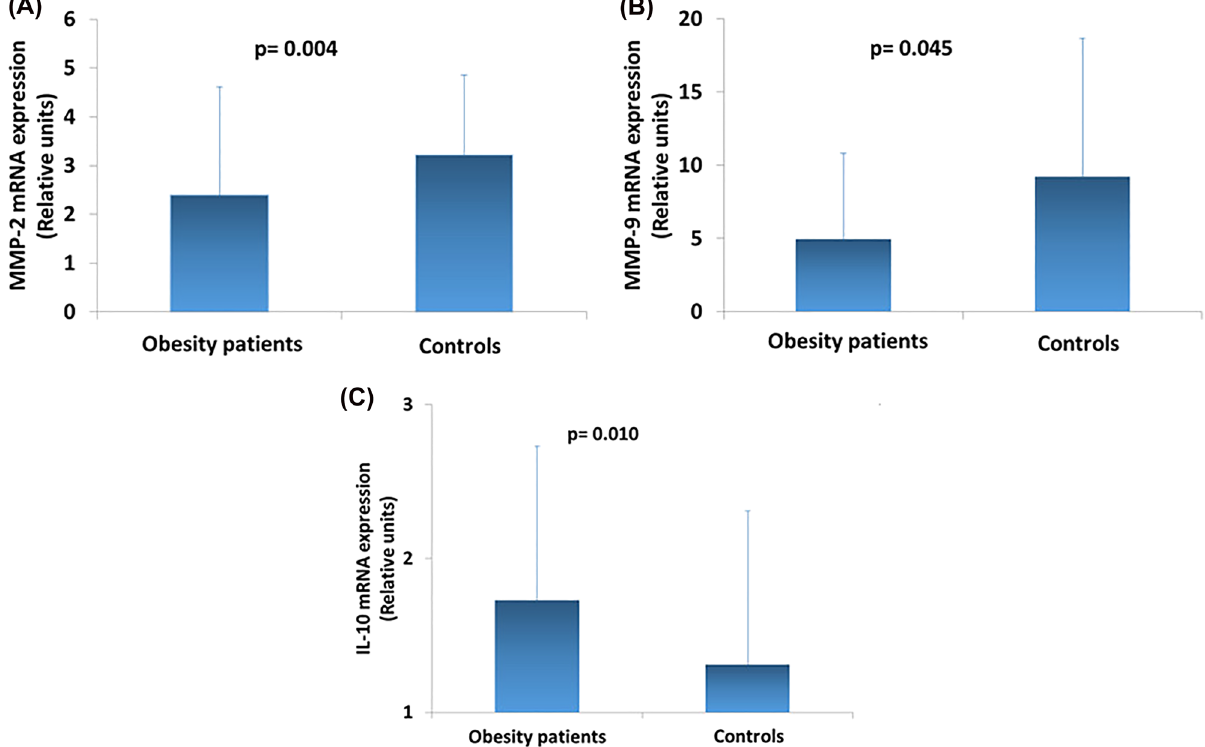
Figure 1: Relative mRNA levels of MMP-2 (A), MMP-9 (B) and IL-10 (C) in patients with obesity and